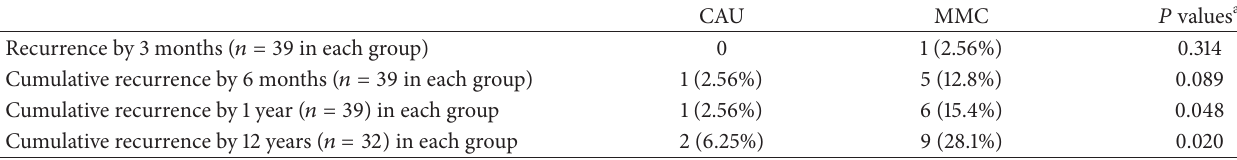
Table 3: Total Number of Recurrences in Conjunctival Autograft and Mitomycin C Groups. CAU MMC 𝑃 values a Recurrence by 3 months ( 𝑛 = 39 in each group) 0 1 (2.56%) 0.314 1 (2.56%)